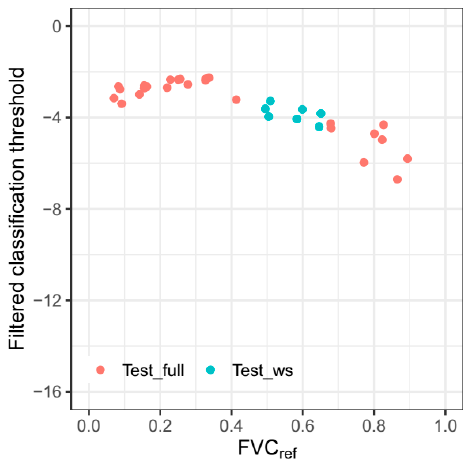
Figure 6. The classification thresholds obtained by a*_I_T 1 with absolute estimation error less than 0.025, varying with reference fractional vegetation cover (FVC ref ).